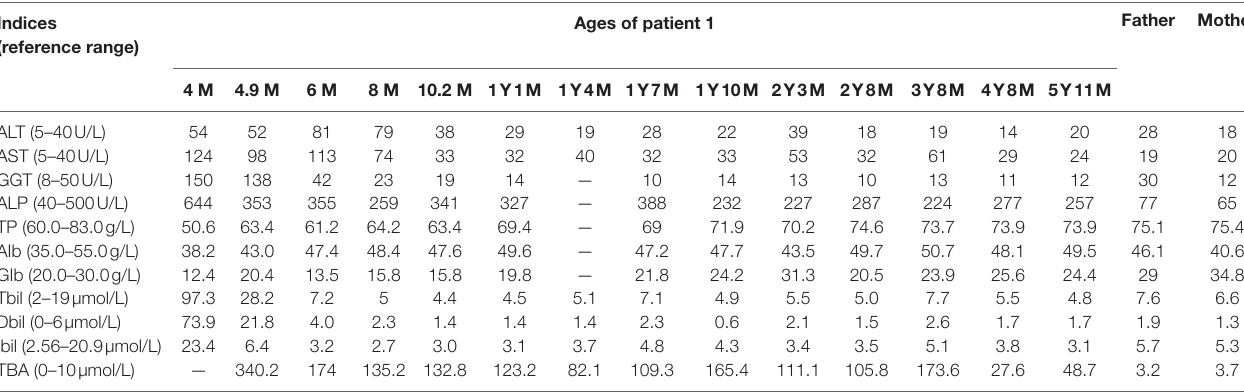
TABLE 1 | Biochemical alterations over time in patient 1 and the parents. Indices (reference